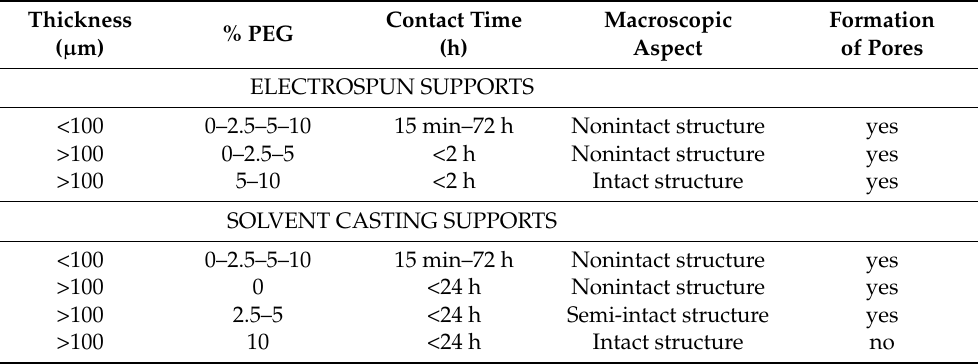
Table 1. Summarized results of tests conducted on all supports in contact with scCO 2 at 35 ◦ C and 170